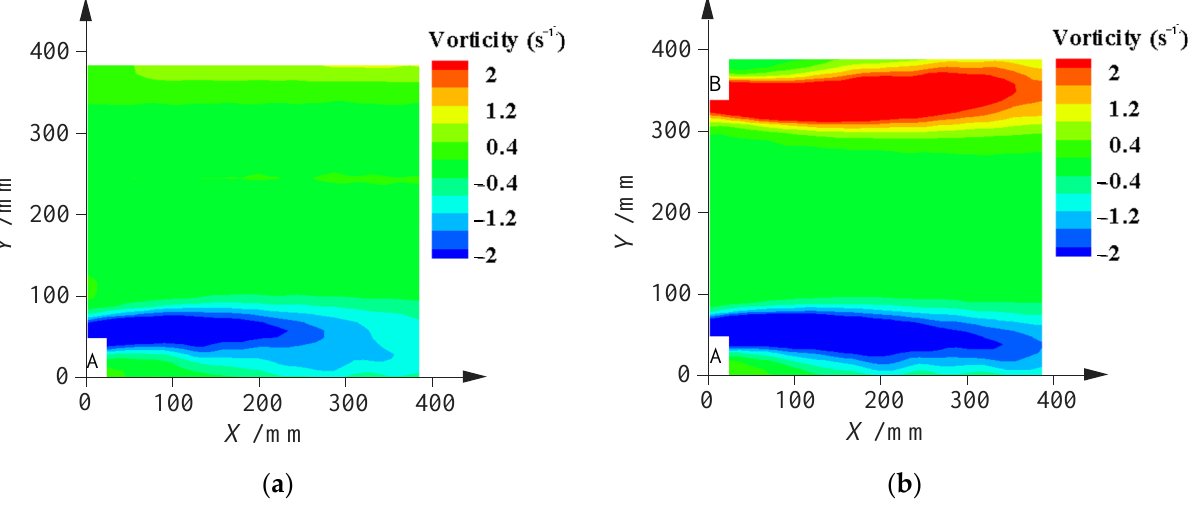
Figure 13. Vertical vorticity in the horizontal plane for ( a ) single groin, ( b ) two symmetrical groins.